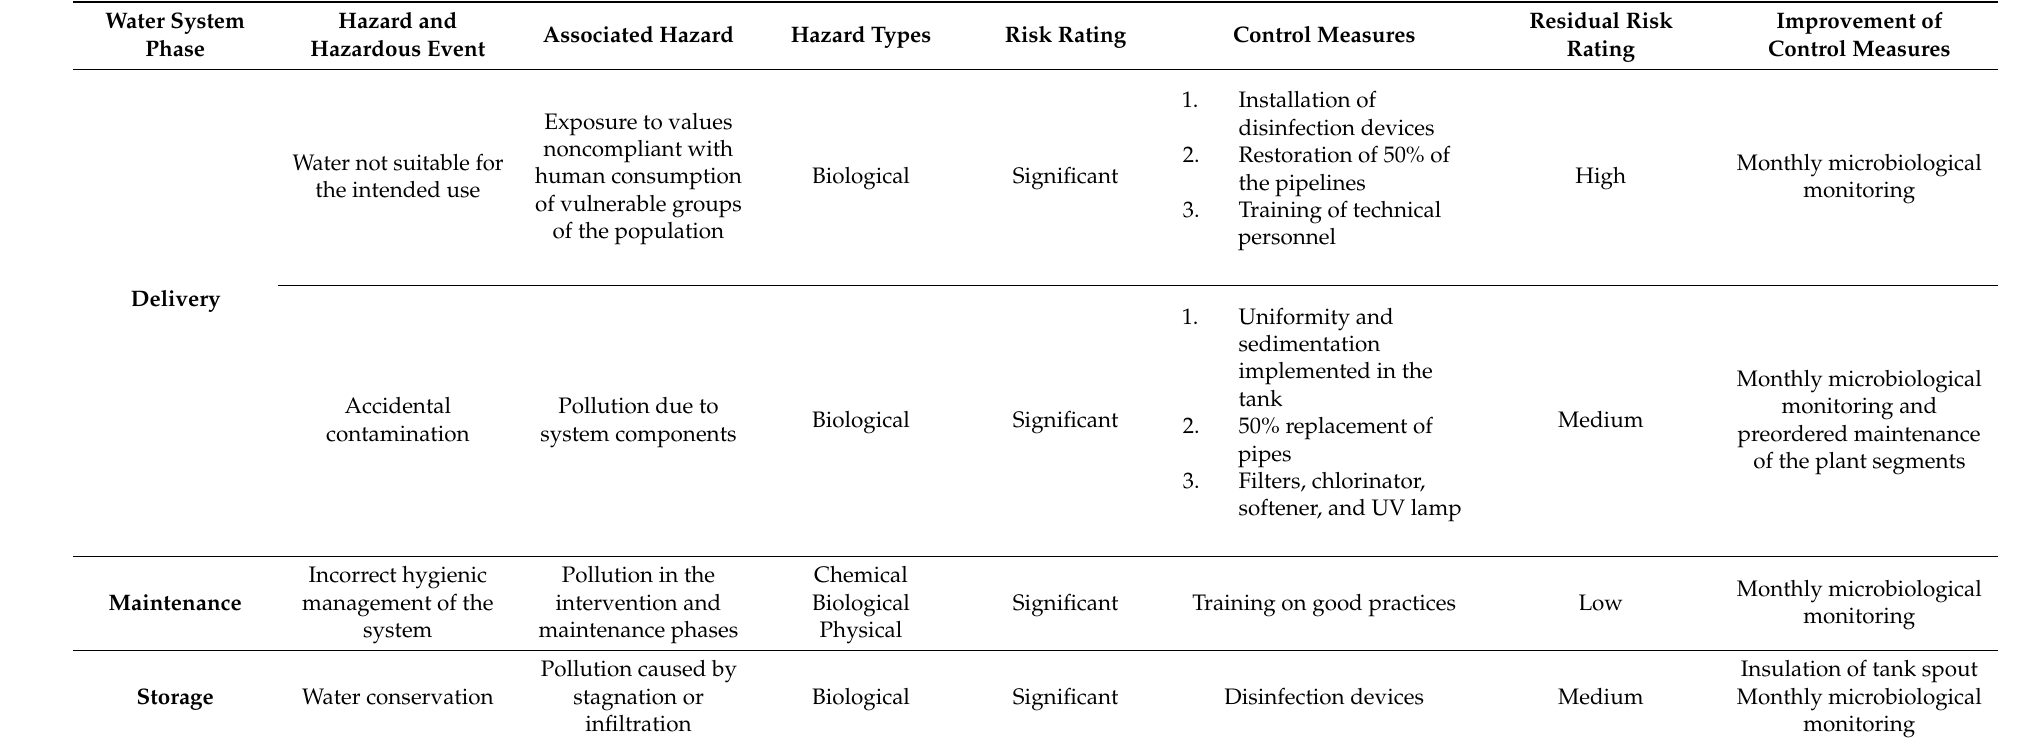
Table 6. Identification of hazards and dangerous events: Case Study